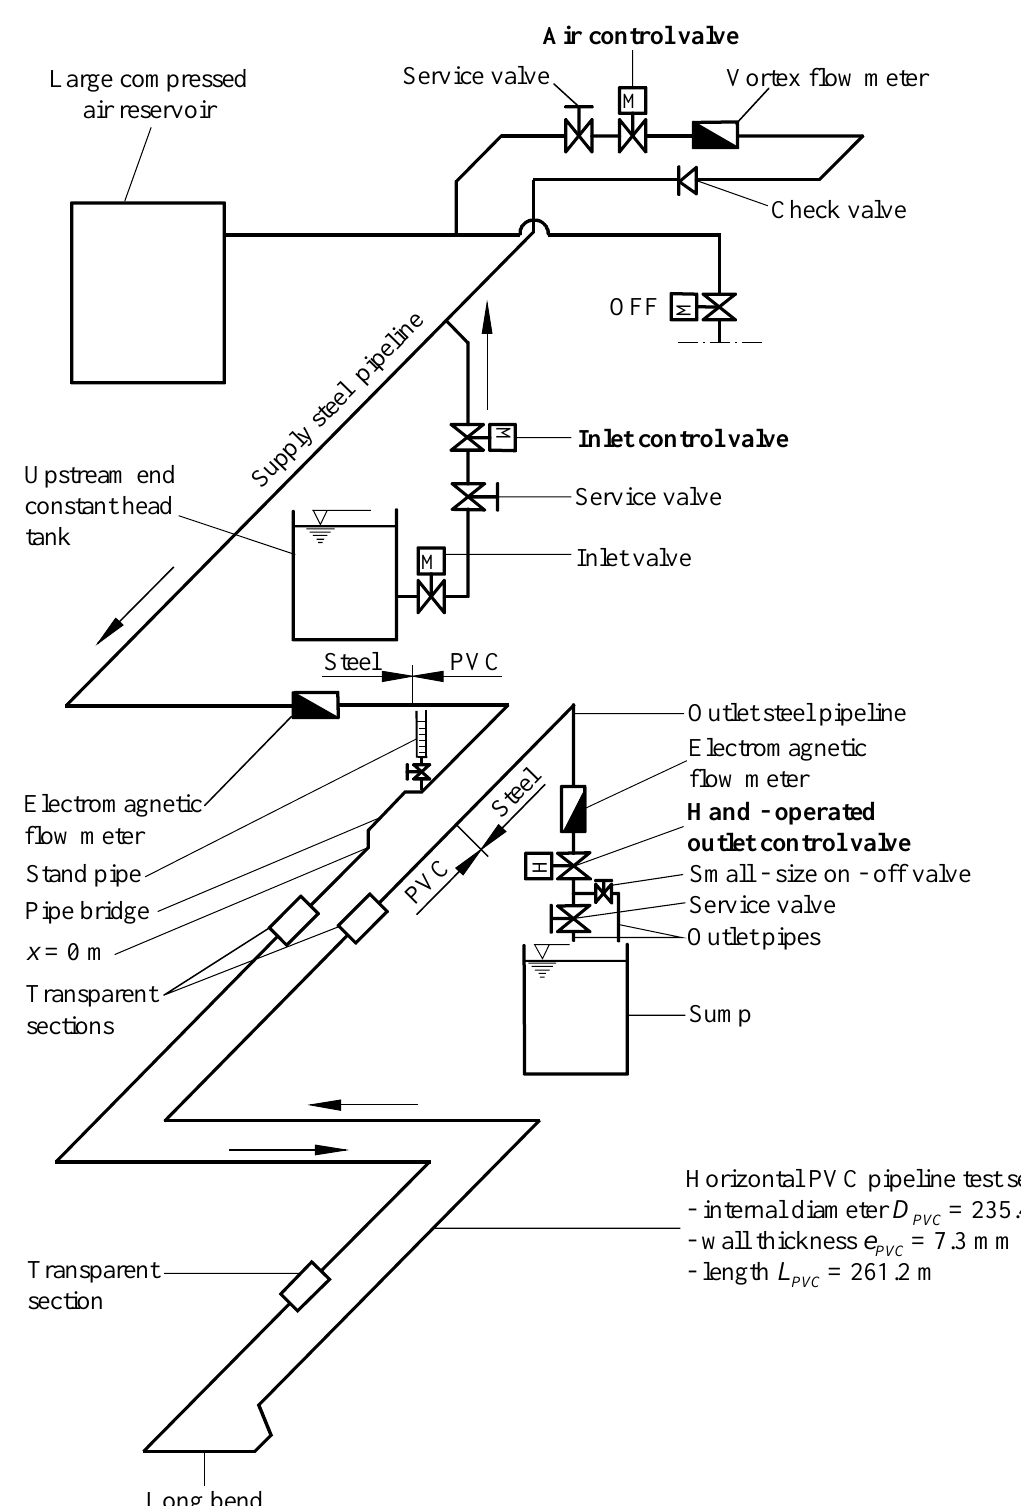
Fig 2. Layout of pipe system apparatus for waterhammer